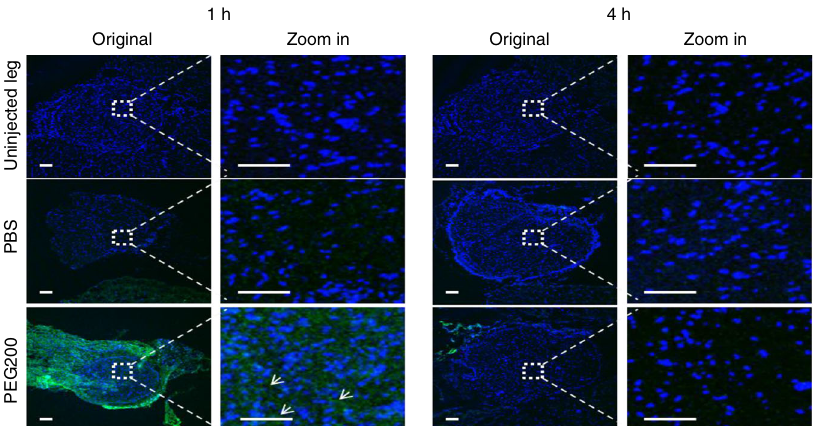
Fig. 4 Representative fl uorescence images of sections of sciatic nerves and surrounding tissues. Tissues were harvested 1 and 4 h after injection of 0.25 mg of fl uorescein sodium in 0.5 mL of PEG200 or PBS. Arrows indicate fl uorescein sodium (green). Blue: cell nuclei stained with 4 ′ ,6-diamidino-2- phenylindole (DAPI). Data are representative of 4 animals in each group. Scale bars, 100